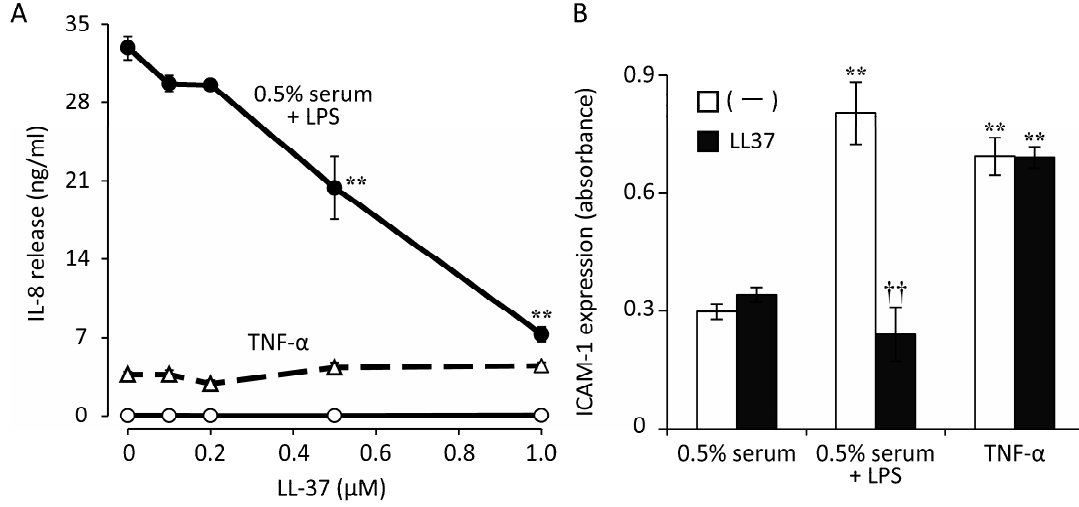
Figure 5. Effects of LL37 on LPS- or TNF- α –induced IL-8 and ICAM-1 expression in human corneal fibroblasts. Cells were incubated first for 2 h with the indicated concentrations of ( A ) or 1 µM ( B ) LL37 and then for 48 h ( A ) or 24 h ( B ) in the additional presence of LPS (100 ng/mL) plus 0.5% human serum (closed circles), of 0.5% human serum alone (open circles), or of TNF- α (10 ng/mL, triangles). The concentration of IL-8 in culture supernatants ( A ) and the cell surface expression of ICAM-1 ( B ) were then determined. ** p < 0.01 versus the corresponding value for cells incubated without LL37 ( A ). ** p < 0.01 versus the corresponding value for cells incubated with 0.5% serum alone; †† p < 0.01 versus the corresponding value for cells incubated without LL37 ( B ). Reprinted with permission from [56].